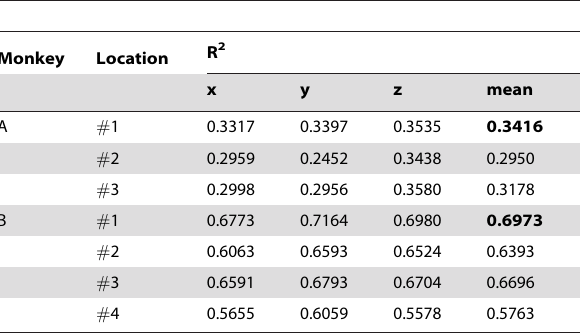
Table 2. Prediction results using location-based electrode selection in the medial-lateral